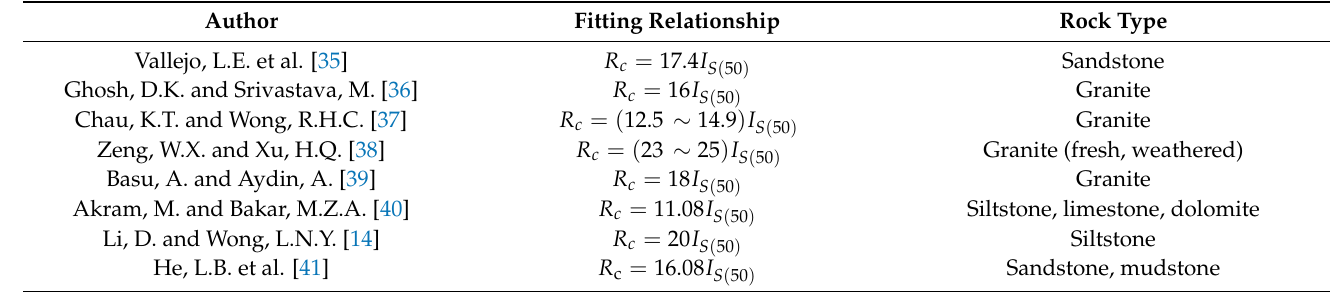
Table 9. Conversion relationship between I s(50) and uniaxial compressive strength.